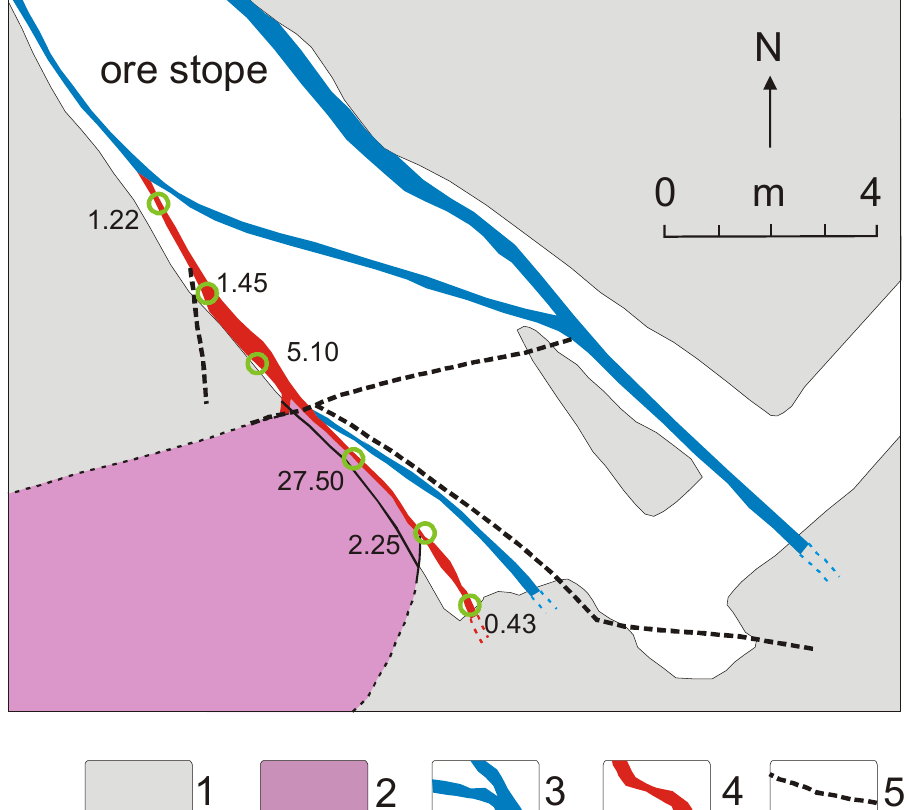
Figure 3. The geological situation of the described ore stope, modified according to the documentation of the Správa uranových ložisek, o.z., P ř íbram. 1—metamorphosed sediments of the Dob ř íš Group; 2—granodiorite porphyrite; 3—hydrothermal vein with base-metal mineralization; 4—hydrothermal vein with Au-bearing mineralization with determined Au contents (ppm); 5—small dislocations.